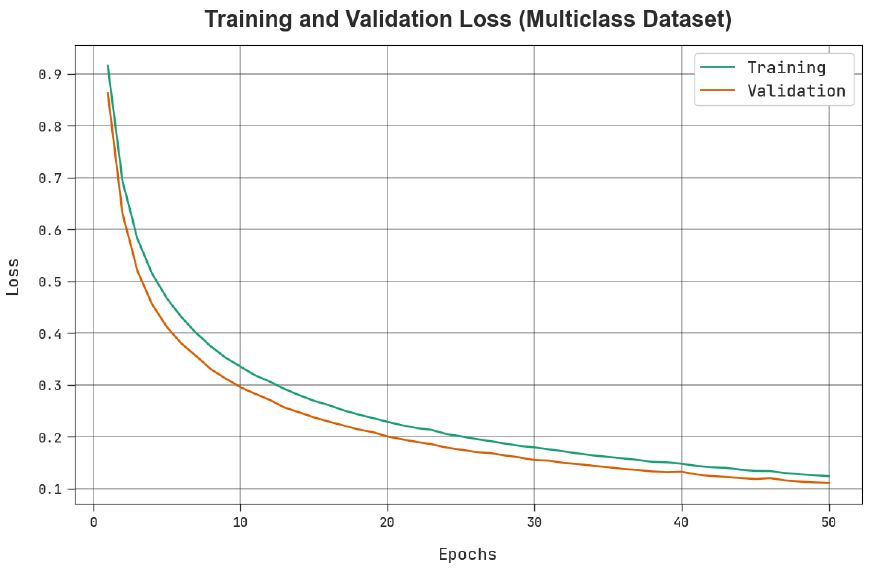
Figure 10. Loss curve of the H3SC-DLIDS approach on multiclass dataset.